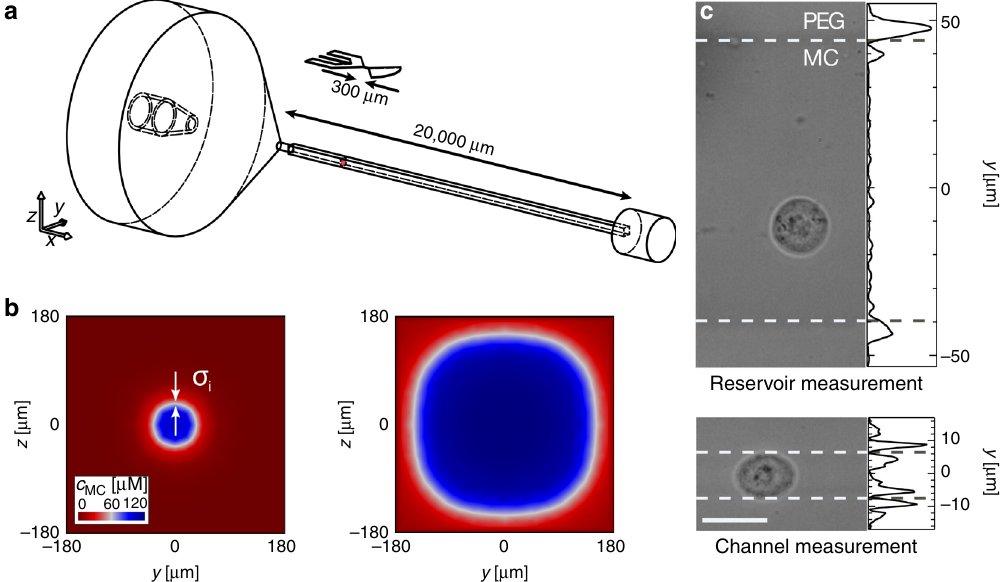
Fig. 4 Virtual channel formation inside a fl ow cytometer glass cuvette. a Technical drawing of glass cuvette and PDMS chip to scale for comparison. Arrows indicate length of constrictions of 2 cm for the cuvette and 300 µ m for the PDMS device. b FEM simulations of concentration distribution for the cross-section of the cuvette performed for sample 114 µ M MC at Q sa = 200 nl s − 1 and sheath 5 mM PEG40000 at Q sh = 1000 nl s − 1 yielding a 80 µ m virtual channel (left). Arrows indicate the stress σ i due to the viscosity mismatch at the interface. Adjusting the fl ow rates to Q sh = 50 nl s − 1 while keeping Q µ m (right). c Representative image of a HL60 cell in a virtual channel of 88 µ m sa constant, enables increasing the diameter of the constriction to 260 diameter (sample 114 µ M MC at Q sa = 200 nl s − 1 , sheath 5 mM PEG40000 at Q sh = 1000 nl s − 1 , top) and inside a virtual channel of 14 µ m diameter (sample 114 µ M MC at Q sa = 15 nl s − 1 , sheath 5 mM PEG40000 at Q sh = 1000 nl s − 1 , bottom). Projected line plots at top and bottom indicate the squared intensity gradient (arb. units) perpendicular to the fl ow direction while center between the maxima identify virtual channel interfaces (white dashed lines). Recording of cells and spheroids inside virtual channels has been repeated six times where a fl uctuation in virtual channel size of 10% has been